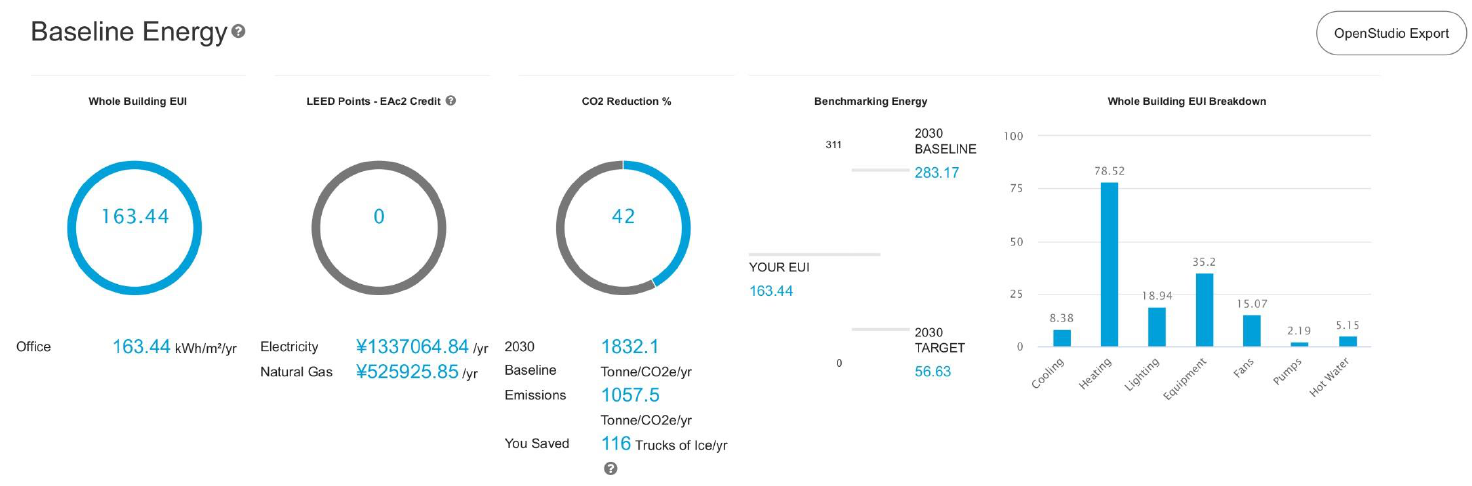
Clean Technol. 2022 , 4 , FOR PEER REVIEW Figure A7. Zone 3-A Shanghai, Shanghai (pre-COVID-19 scenario). Figure A7. Zone 3-A Shanghai, Shanghai (pre-COVID-19 scenario).